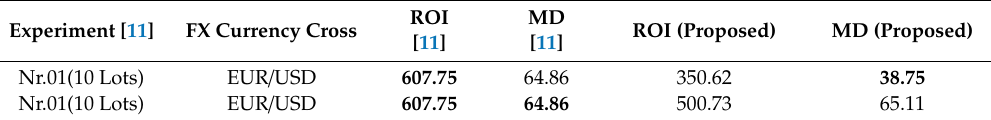
Table 2. Trading Performance